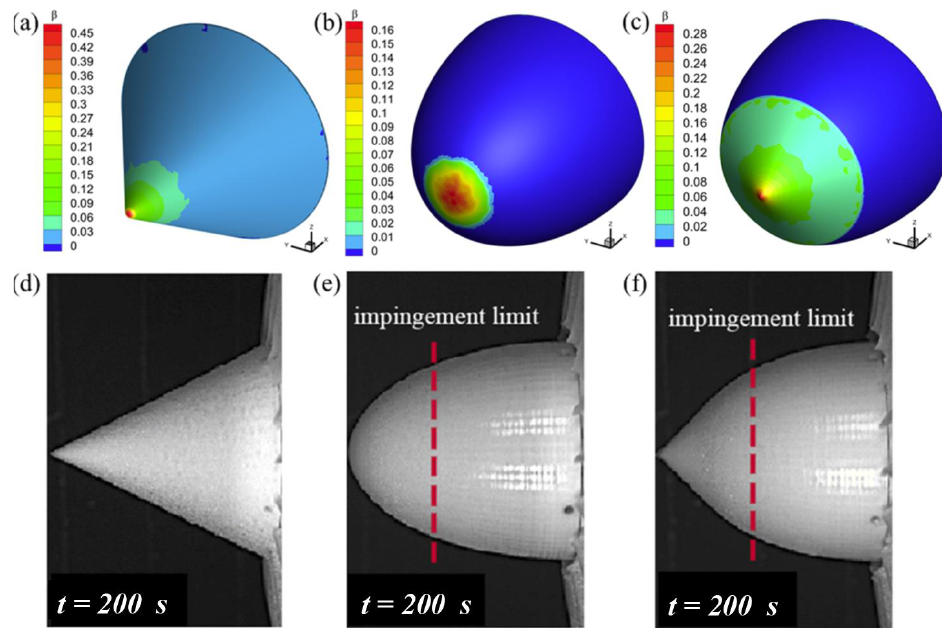
Figure 4. Water droplet collection coefficient β on three types of spinners: ( a ) conical-shaped spinner; ( b ) elliptical-shaped spinner; ( c ) coniptical-shaped spinner. Ice over the surfaces of three types of spinners under the rime icing condition [17] ( d – f ).